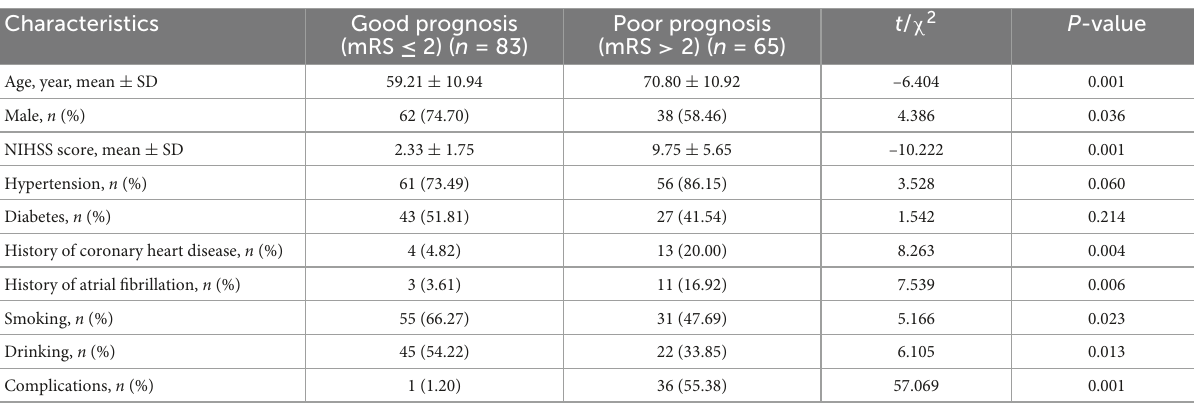
TABLE 1 Baseline demographic and clinical characteristics.